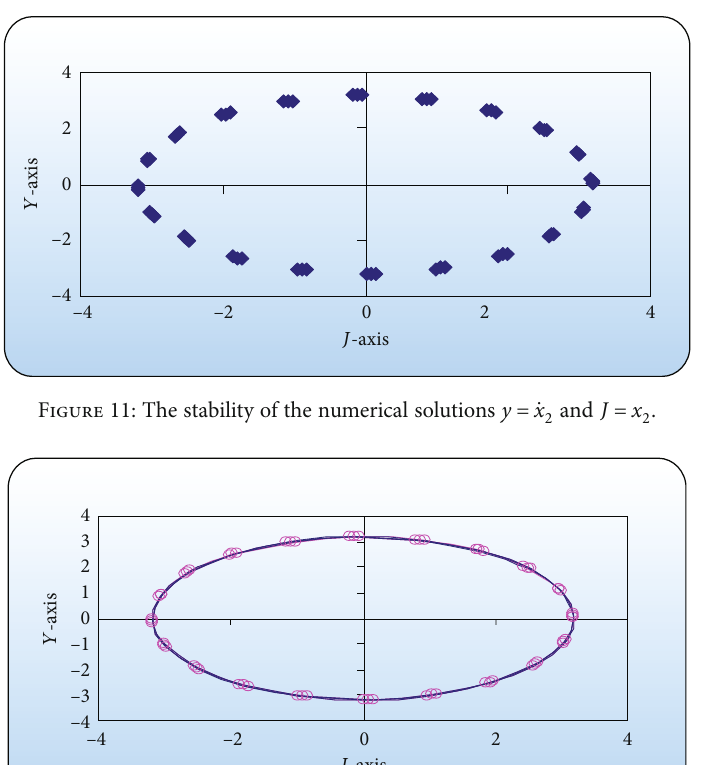
Figure 10: The stability of the analytical solutions y = _ x